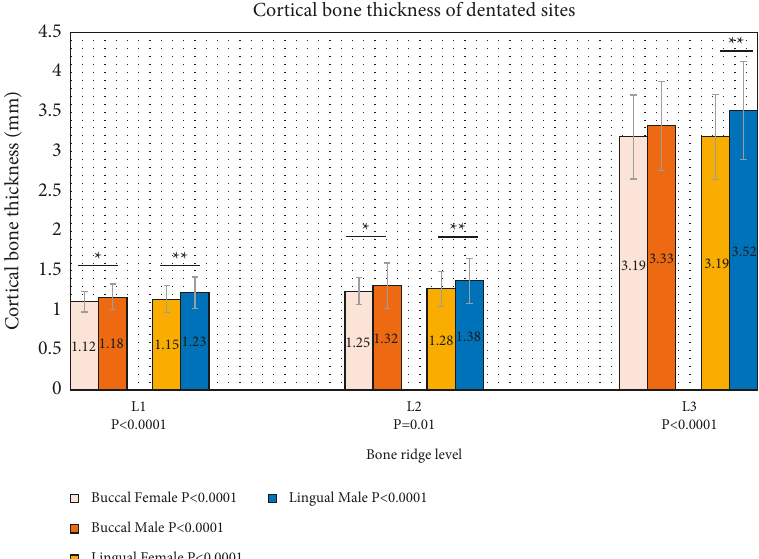
Figure 3: Cortical bone thickness of dentate site according to levels in female ( n � 80) and male ( n � 80) groups. P values in the legend represent the significance between bone thickness at 3 levels in the same site and gender group. P values in X axis represent the significance of bone thickness in the group level. ( ∗ ) Significant difference. ( ∗∗ ) Highly significant difference.